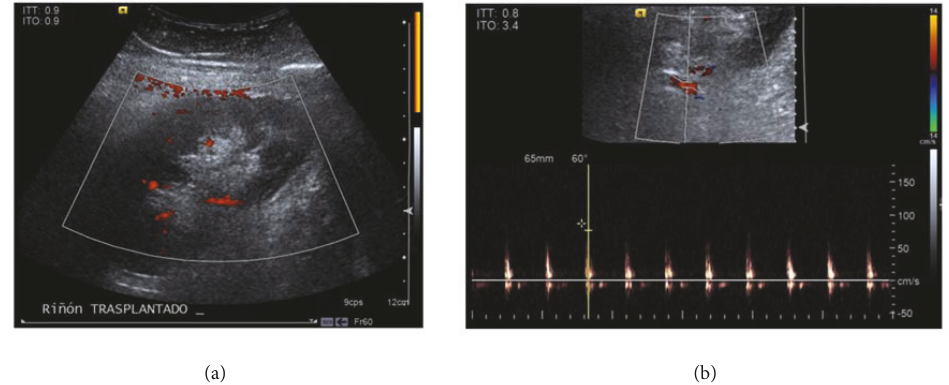
Figure 2: Doppler ultrasound . (a) Graft of the patient shows the absence of blood flow at the level of the renal cortex, arcuate arteries, interlobular arteries, and arterial anastomosis. (b) Duplex mode shows an arterial biphasic waveform with delayed acceleration, decreased systolic peak, and increased flow in diastole, which is a suggestive pattern of ischemia.